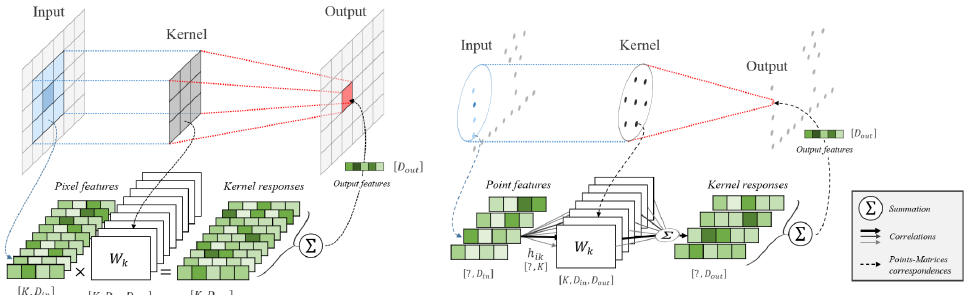
Figure 1. Pictorial representation of pixel and point convolutions. ( Left ) Pixel features localized by pixel locations are generated by convolving a set of learned kernels over the previous layer’s feature set. ( Right ) Point features localized by point locations are generated by convolving a set of learned kernels over the previous layer’s feature set. Pixel convolution is seen as a special case of point convolution where the influence of each kernel weight is uniform at each pixel. Reprinted, with permission, from [20]. ©2022